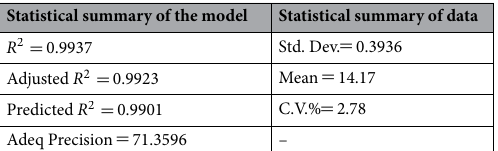
Statistical summary of the